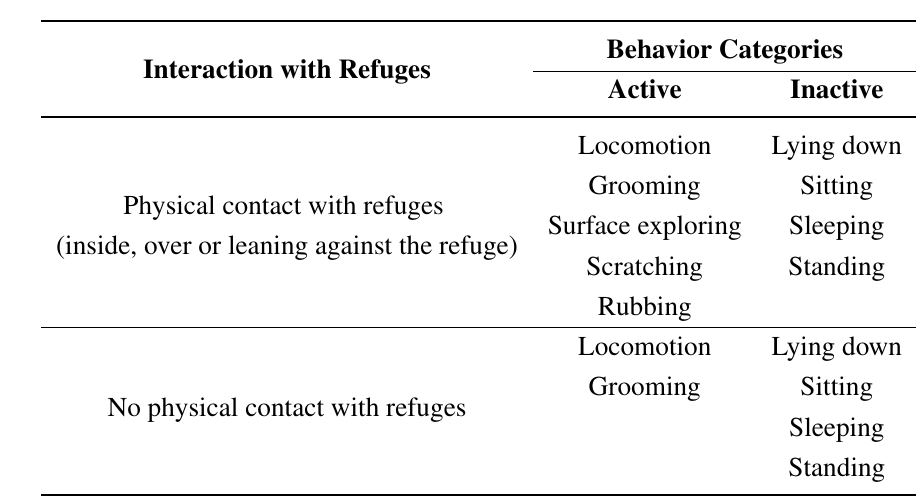
Table 1. Ethogram used in Experiment